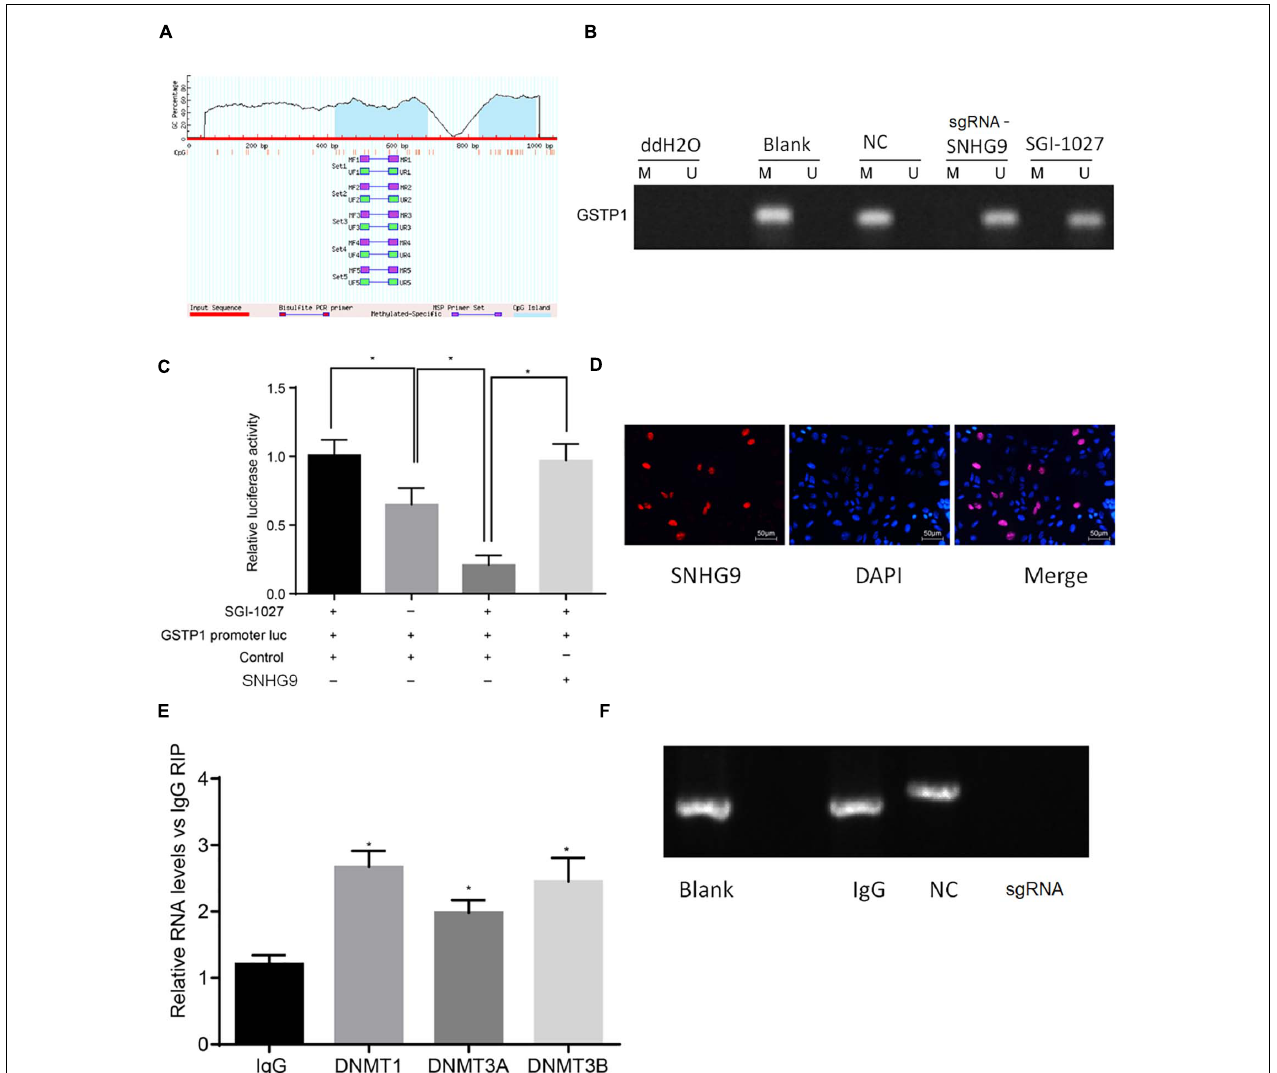
FIGURE 4 | SNHG9 promotes GSTP1 promoter methylation by recruiting methylated proteins. (A) localization of GSTP1 methylated SNHG9 and CpG Island predicted by bioinformatics; (B) Ms-PCR detected the methylation level of GSTP1 promoter after sgRNA-SNHG9 and SGI-1027 treatment. (C) Double luciferase reporter gene assay confirmed the binding of SNHG9 to GSTP1 promoter. (D) FISH analysis of lncRNA SNHG9; The RIP analysis of panel (E) , SNHG9 combined with DNMT1, DNMT3A, and DNMT3B; CHIP detection of GSTP1 promoter in panel (F) , IgG, and